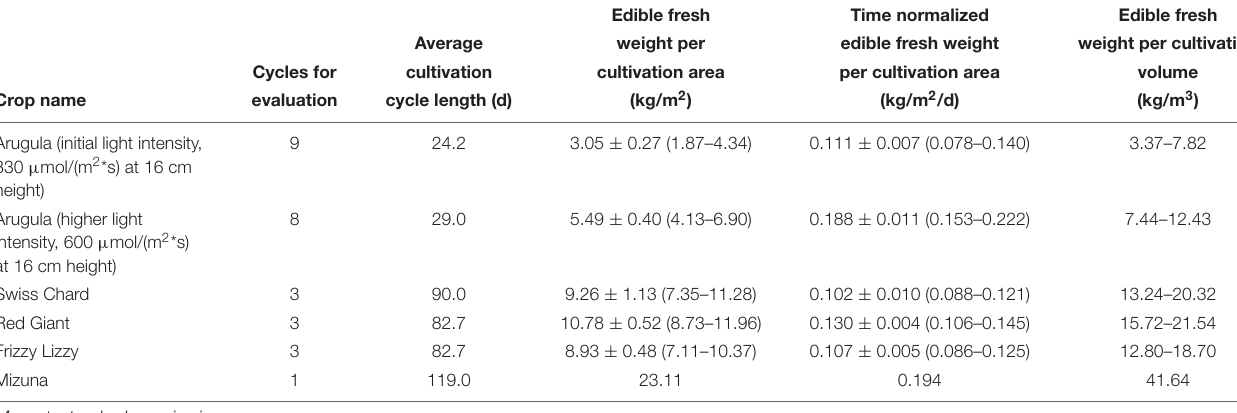
TABLE 6 | Leafy greens edible fresh weight production values.